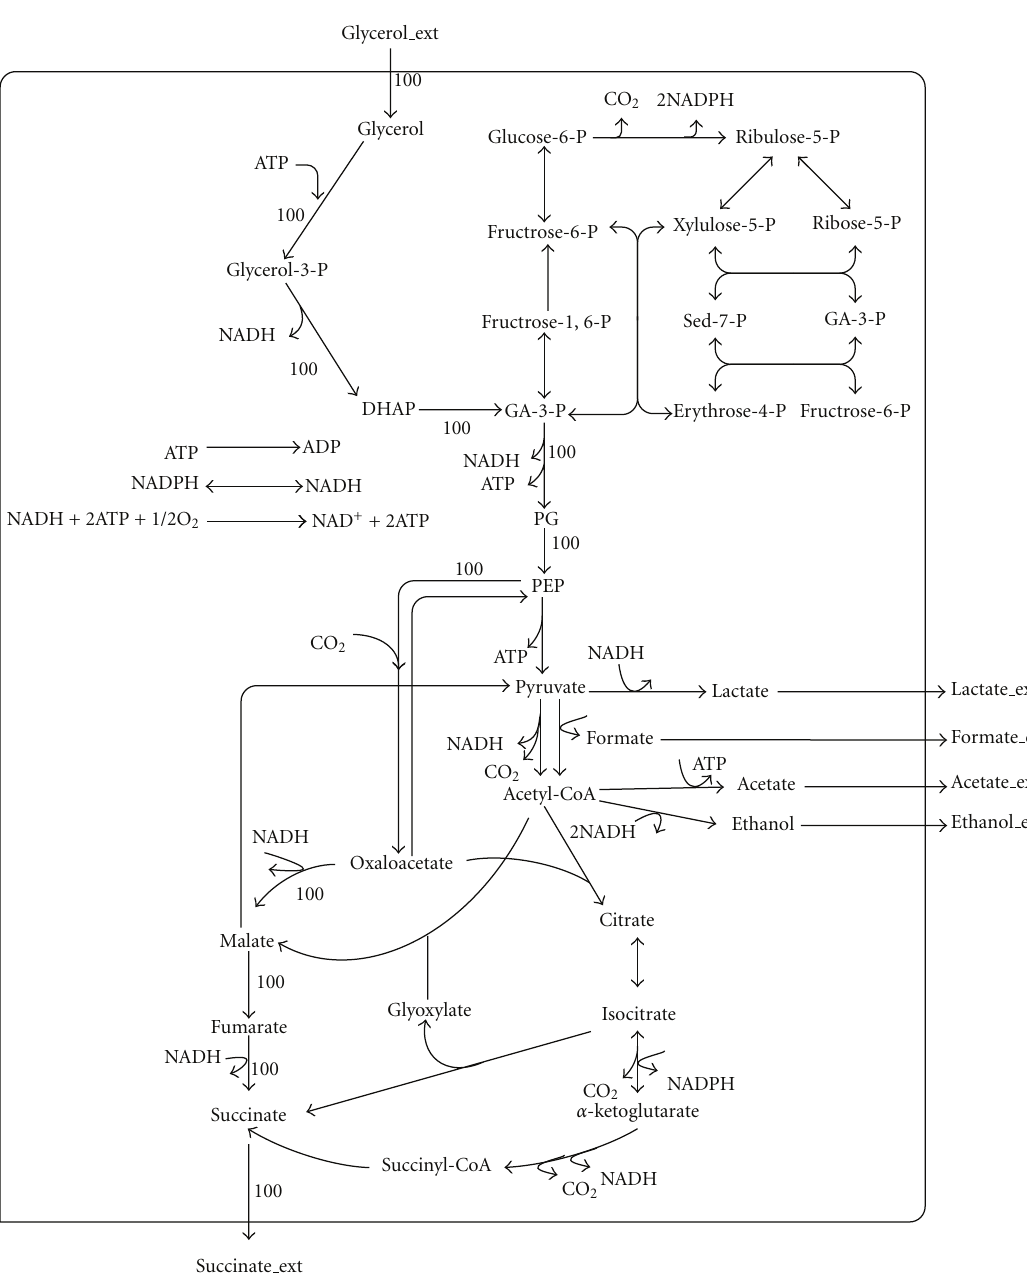
The influence of flux distribution at PEP node was shown in Figure 7(a). The succinate yield increased from 0.5 mol/mol to 1.0 mol/mol when R(40,17) increased from 0 to 1.0. The results showed that increasing the flux distribution from PEP to oxaloacetate was beneficial for succinate production. For acetyl-CoA node, it was consumed in reactions R22, R44, R50, and R53 which are catalyzed by citrate synthase, aldehyde dehydrogenase, malate synthase, and phosphate acetyltransferase, respectively. The flux ratio was denoted as